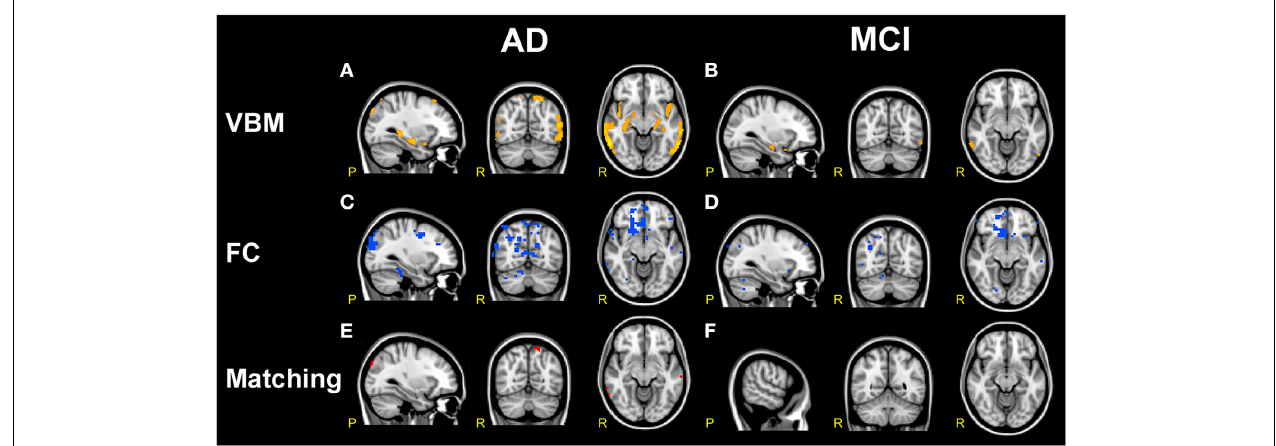
FIGURE 7 | Comparison of structural and functional changes in AD and MCI. (A,B) VBM analysis . AD subjects compared to HC (A) show large areas of GM atrophy (orange) in bilateral mesial-temporal network. MCI subjects compared to HC (B) show sparse areas of GM atrophy (orange) in left and right hippocampus, left amygdala, parahippocampal gyrus, precuneus and superior temporal gyrus. AD show more extended areas of atrophy than MCI.